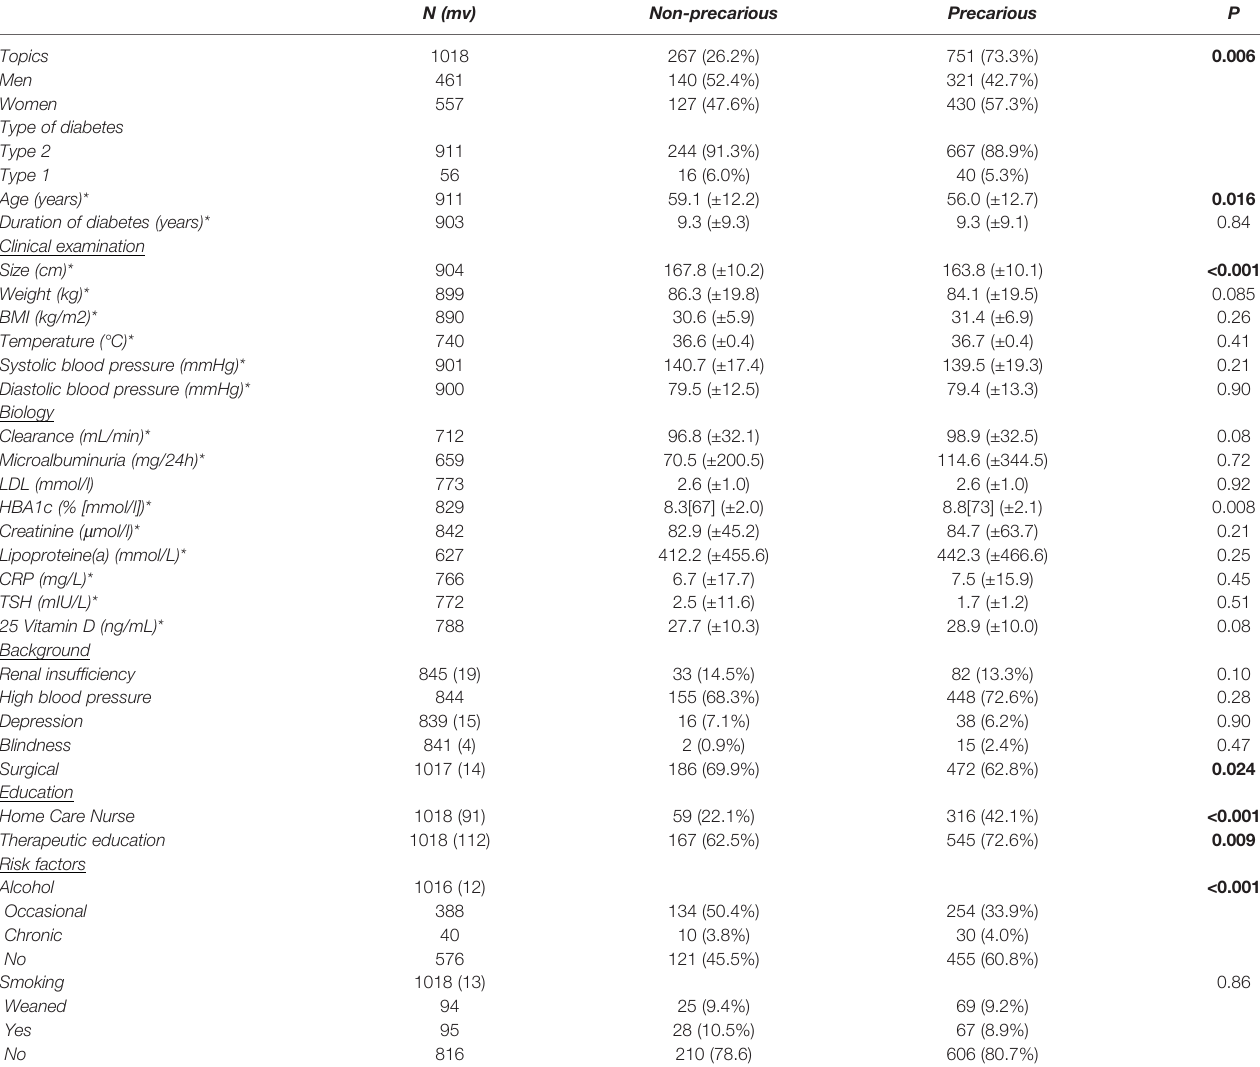
TABLE 2 | Medical characteristics of the study population according to precariousness.